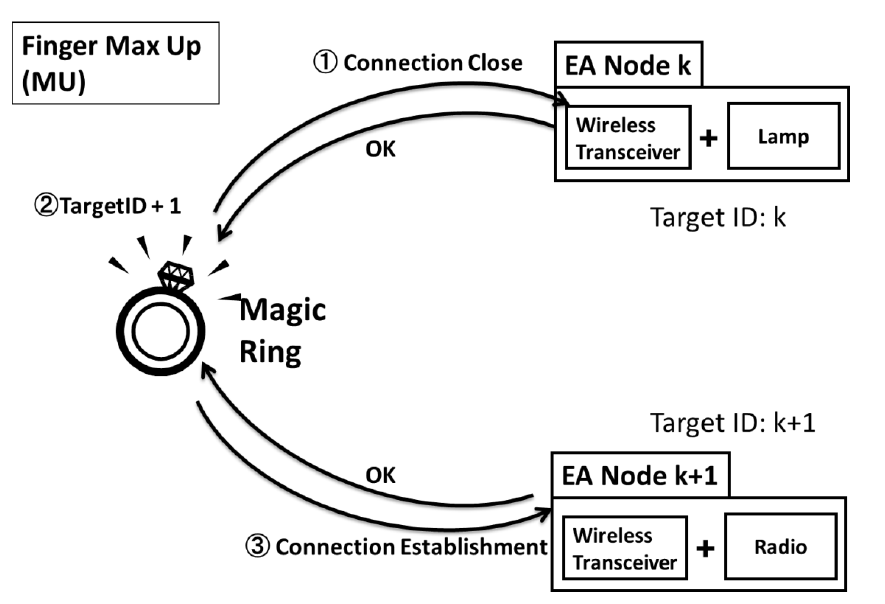
Figure 6. An example of target switching process: finger Max Up (MU) is performed for the switching of the control target from EA-Node k to EA-Node k +